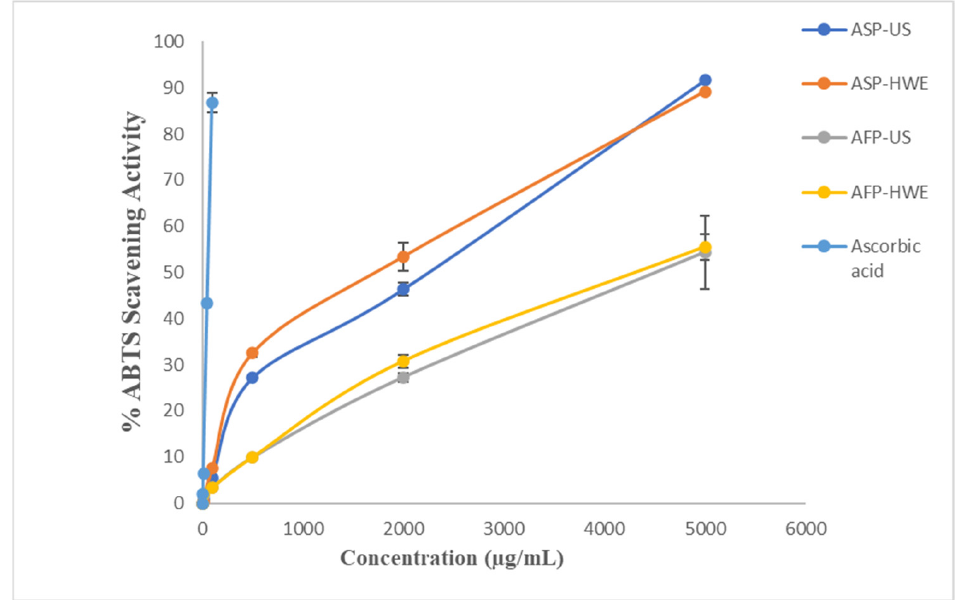
Figure 4. The ABTS scavenging ability of polysaccharides extracted from Ajwa seed and flesh. Results are presented as means ± standard deviations ( n = 3). Differences are statistically significant if p < 0.05 when compared to the